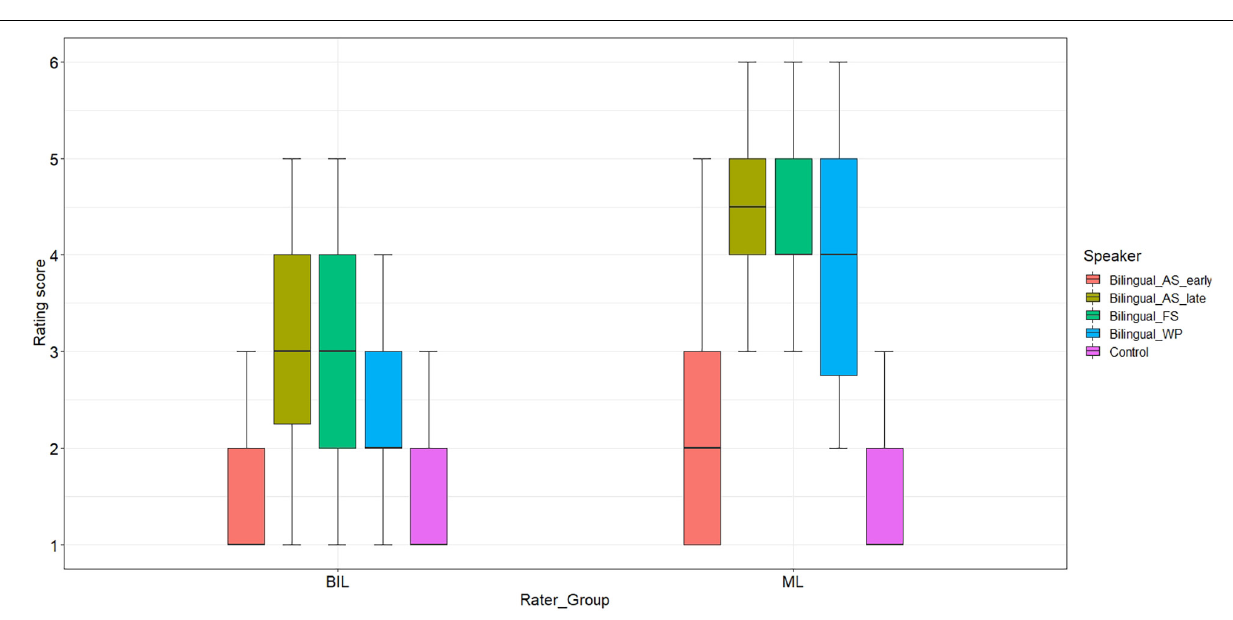
rating score from the BIL rater group (AS_late: Mdn = 3.0, min- max = 1.0–5.0; FS: Mdn = 3.0, min-max = 1.0–5.0; and